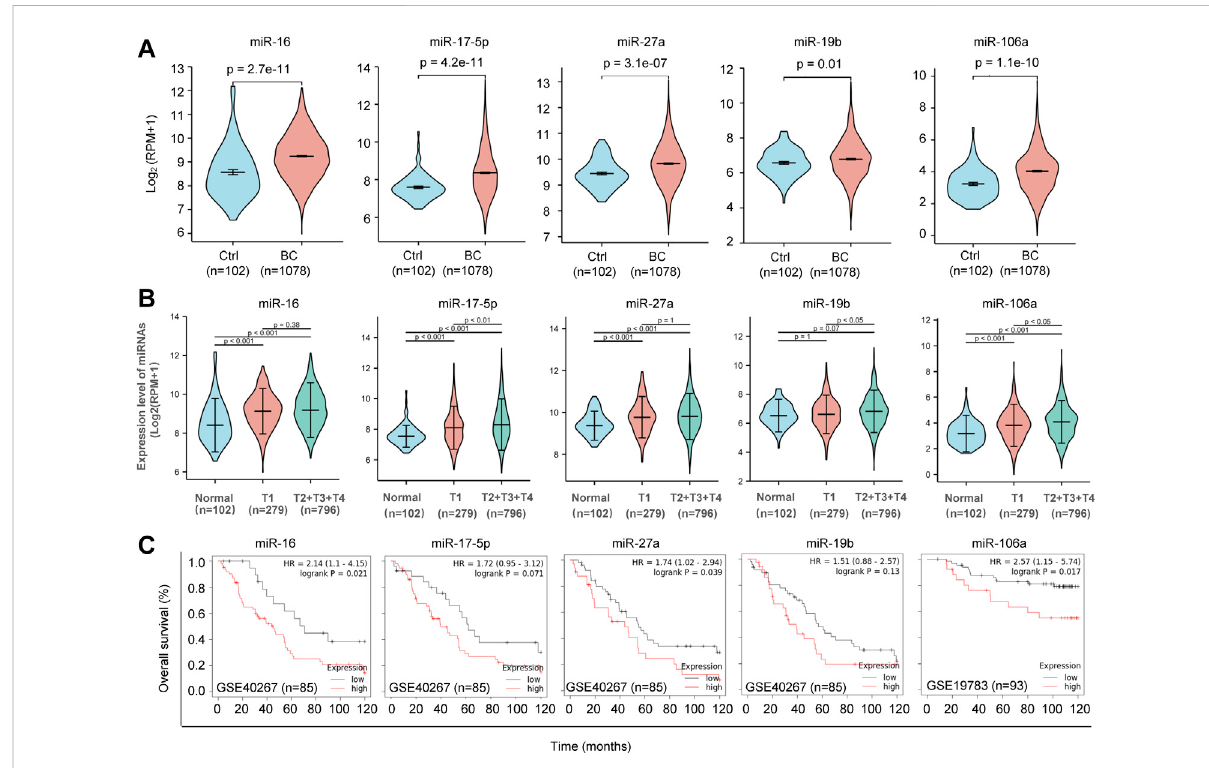
FIGURE 3 Clinical relevance of the fi ve candidate miRNAs. (A) . Violin Plots showing signi fi cant upregulation of miR-16, miR-17, miR-27a, miR-19b and miR-106ain1,078 BCpatients and102 normal controls. TCGAdatabasewasappliedfor analysis. (B) . Tumorstage-basedanalysis ofmiR-16, miR-17, miR-27a, miR-19b and miR-106a in 102 normal controls, 279 BC patients at tumor stage T1 and 796 BC patients at tumor stage later than T1. (C) Kaplan-Meier survival curvesshowing negativecorrelations between theoverall survival rate and theexpressionlevels ofmiR-16,miR-17, miR- 27a, miR-19b and miR-106a in BC,